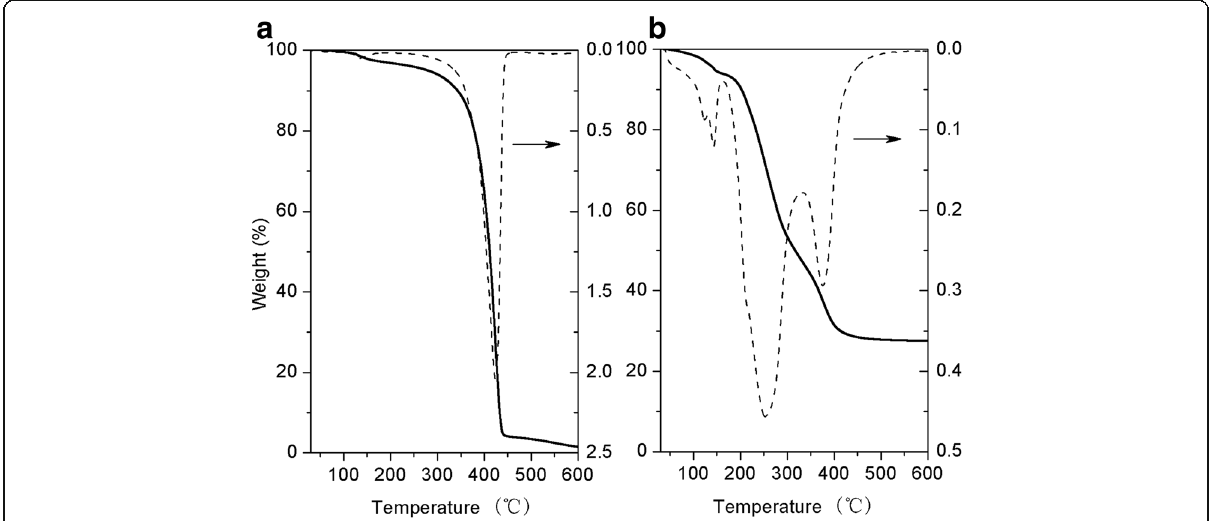
Fig. 4 TGA and DTG curves for a HPG and b Au@DSHPG-2 at the heating rate of 10 °C min −